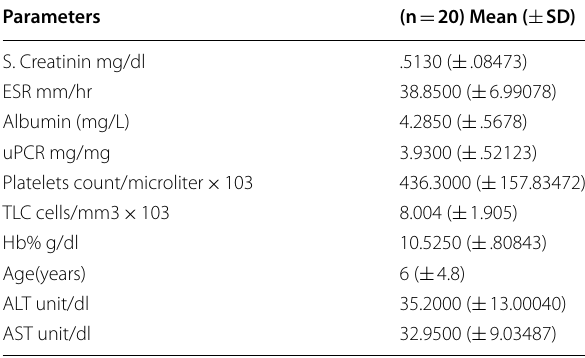
Table 3 Clinical and biochemical data of the SRNS patients with PLCE1 mutations